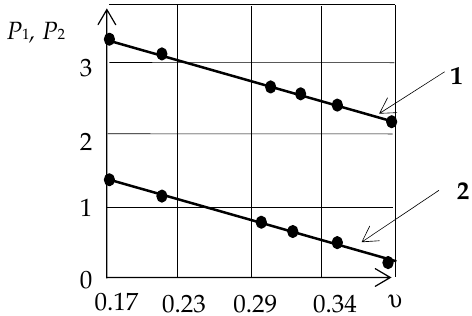
Figure 3. The dependence of the ratio of the ellipse’s axes on the Poisson’s ratio.